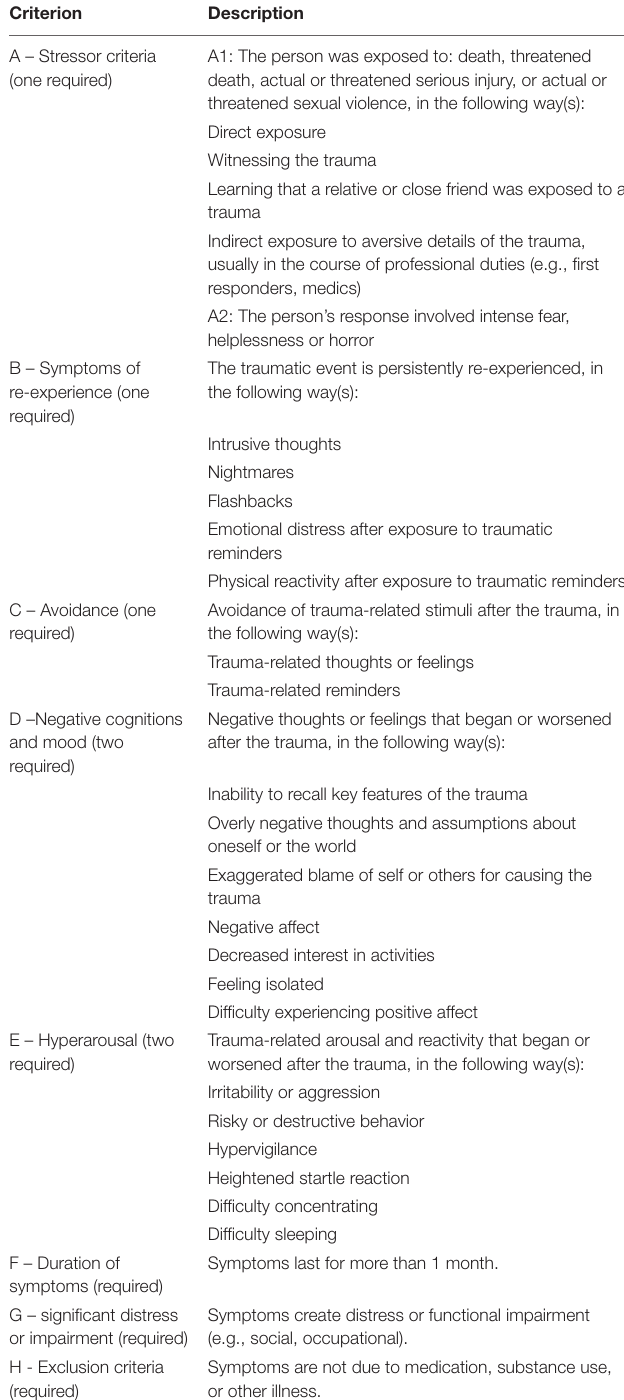
TABLE 1 | DSM-V diagnostic criteria for PTSD. Criterion